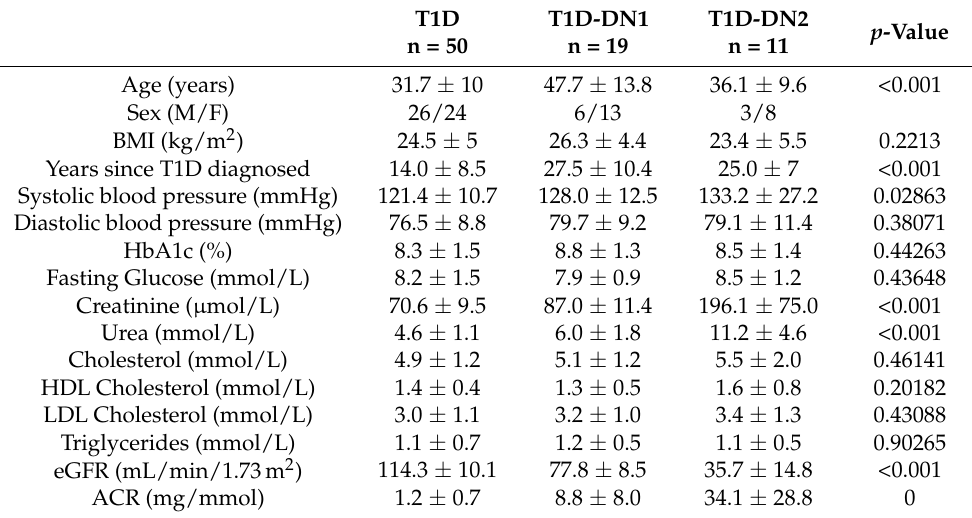
Table 1. Characteristics of the studied